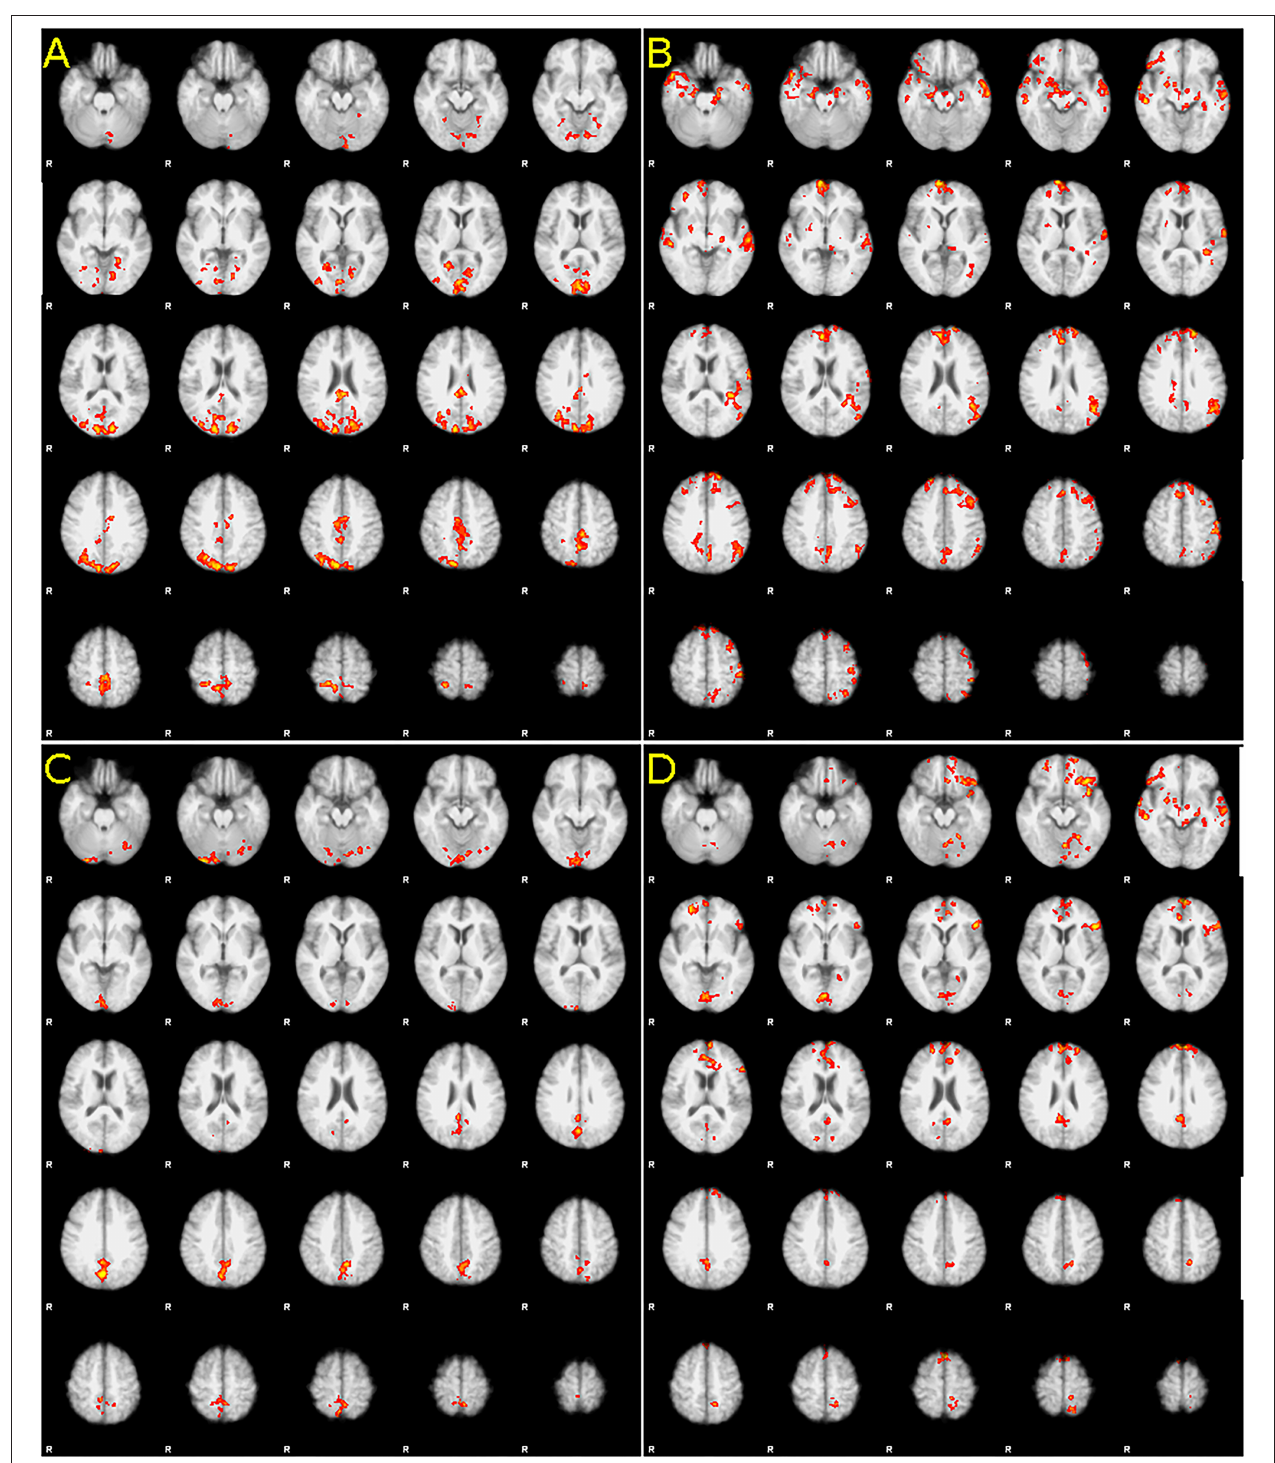
FIGURE 1 | Difference in activation between [ (A,C ), left column) baseline and 3 months after baclofen pump implantation, and [ (B,D) , right column] 3 and 12 months after implantation. Increase in foot in both, (A) baseline and 3 months comparison and (B) 3 and 12 months, (C) Increase in hand in the first 3 months, and decrease (!) (D) between 3 and 12 months. Statistic images were thresholded non-parametrically using clusters determined with Z > 1.6 and a (corrected) cluster significance threshold of P = 0.05. For full statistical output, please see Supplementary Materials .